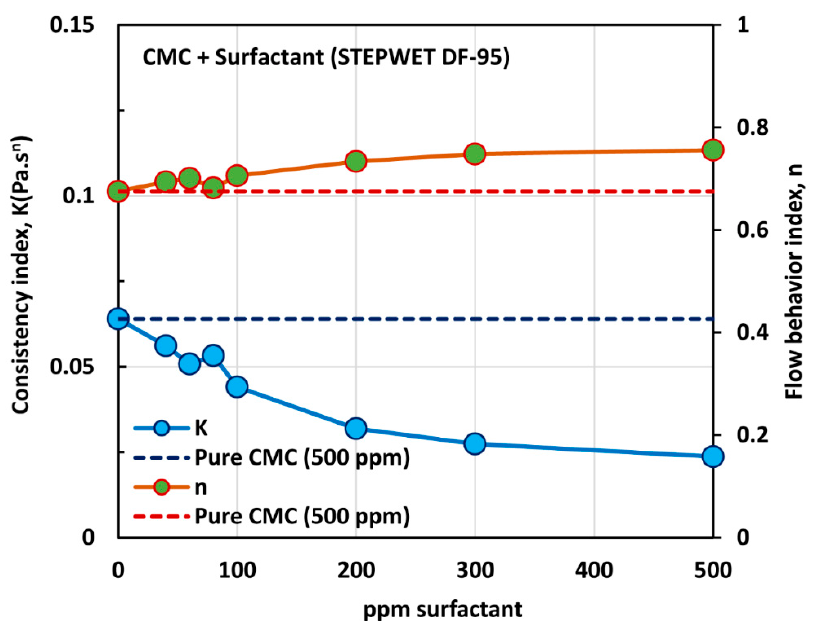
Figure 6. Variations of consistency index, K , and flow behavior index, n , for mixtures of anionic polymer, CMC, and anionic surfactant, Stepwet DF-95, with the increase in surfactant concentration, at a fixed polymer concentration of 500 ppm.